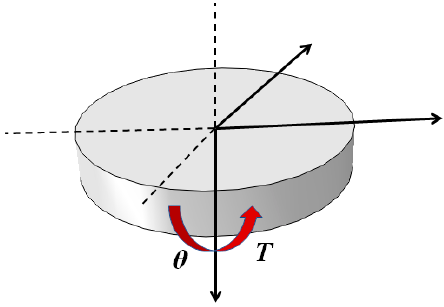
Figure 21. Circular shallow foundation [33].